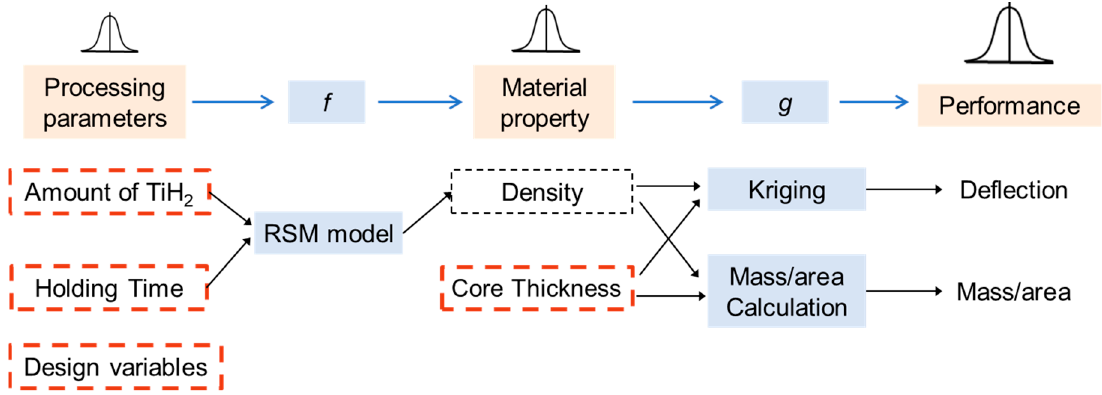
Figure 6. Hierarchical design flow of sandwich panel. RSM: response surface model.